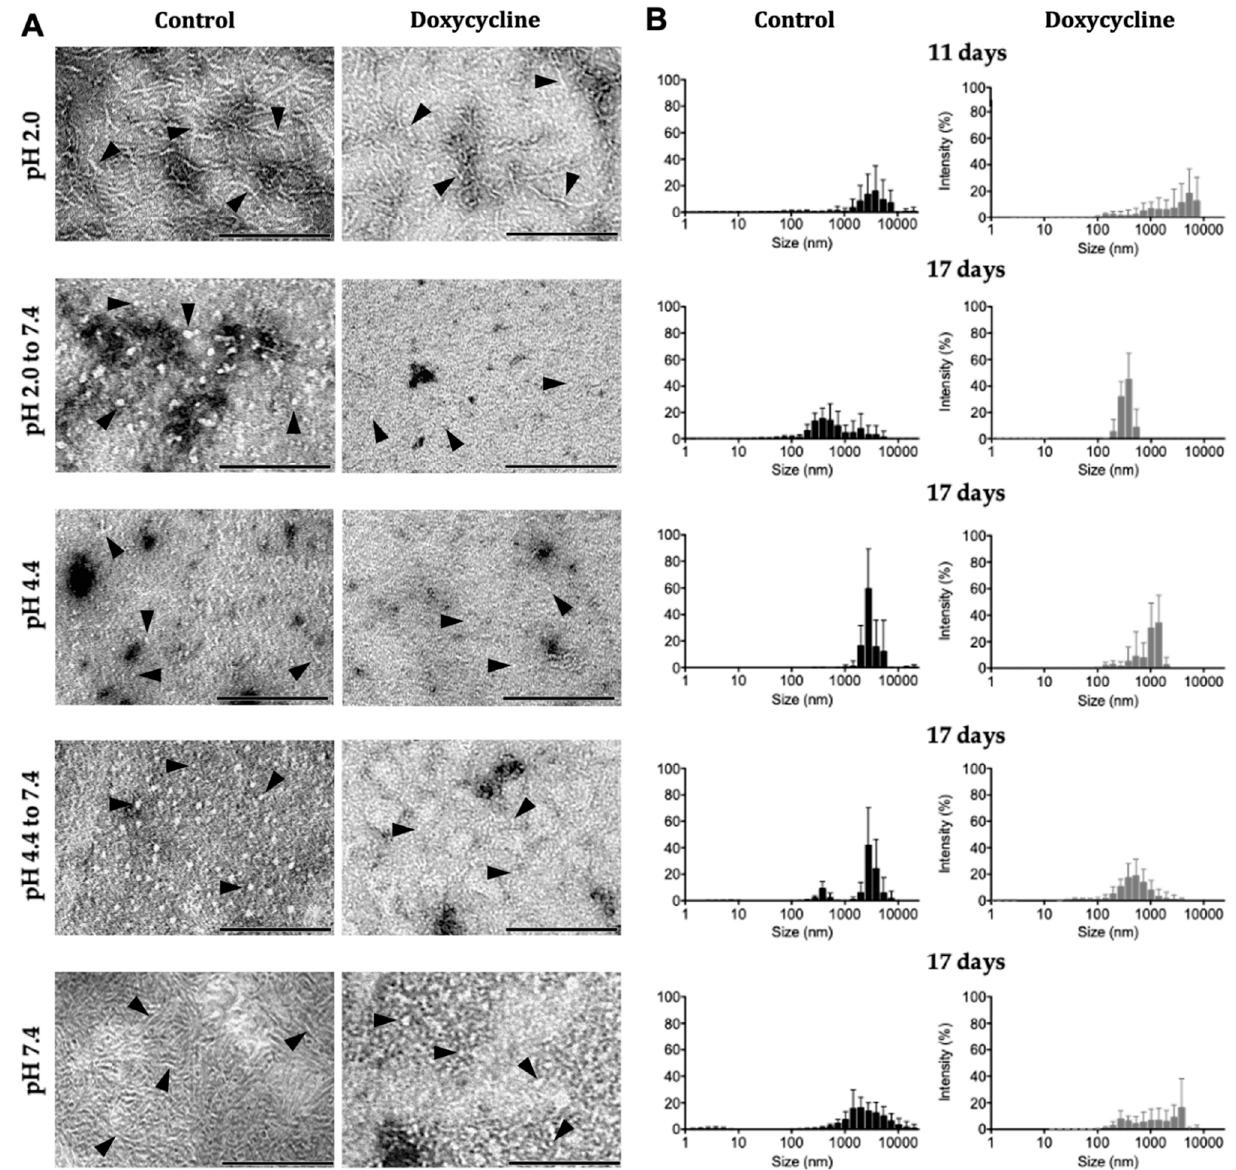
Figure 2. Analysis of the effect of doxycycline on preformed TTRwt aggregates and fibrils. TTRwt amyloid species (3.6 µ M) assembled at pH 2.0 (pH 2.0), pH 2.0 followed by pH adjustment to 7.4 (pH 2.0 to 7.4), pH 4.4 (pH 4.4), pH 4.4 followed by pH adjustment to 7.4 (pH 4.4 to 7.4), and induced by heating at pH 7.4 (pH 7.4) were incubated both in the absence (control) and presence of 50 × molar excess of doxycycline (180 µ M) for the indicated period of time and analysed by ( A ) TEM and ( B ) DLS. The scale bars represent 200 nm, and the arrows indicate some of the amyloid structures ob- served.